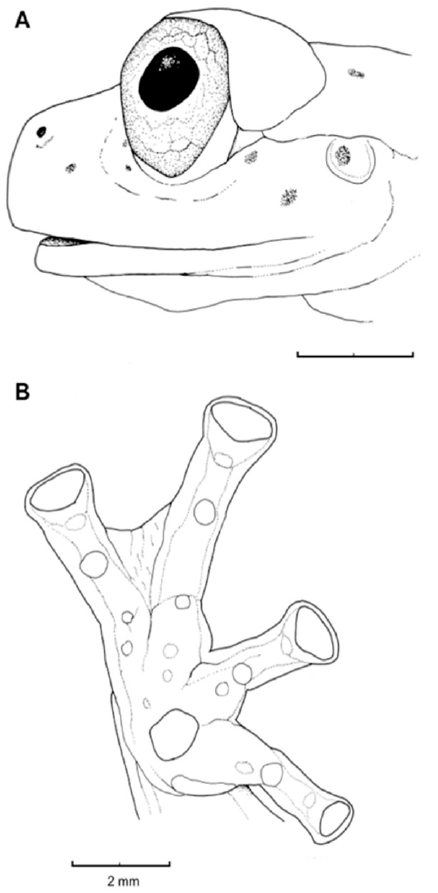
Figure 96. Espadarana prosoblepon , KU 132462. ( A ) Head in lateral view. ( B ) Hand in ventral view. Illustrations by Juan M. Guayasamin Color in life (Figure 95): In Costa Rica, dorsal surfaces green dorsum with dark spots [148]. About one-half of Honduran specimens lack small dark dorsal spots [84]. In Ecuador, several color patterns have been reported: (1) Uniform green dorsum; (2) dorsum green with dark spots; (2) dorsum green with yellow spots; (3) dorsum green with dark and yellow spots, separated from each other; and (4) dorsum green with dark spots surrounding yellow spots, forming false ocelli. Iris varies from greyish white to pale bronze with fine dark reticulation, to silvery white with thick black reticulations. Green bones; whitish cream upper lip; white venter that is transparent posteriorly; ventrolateral margins of forearm and tarsus lacking white coloration. Color in ethanol: As described above, but green turns into lavender and yellow spots turn white. Some individuals (e.g., KU 132463–64) present black and smaller white spots on dorsum. White parietal peritoneum covering about anterior 60% of venter. Translucent peritonea cover digestive tract, liver, kidneys, and urinary and gall bladders; white